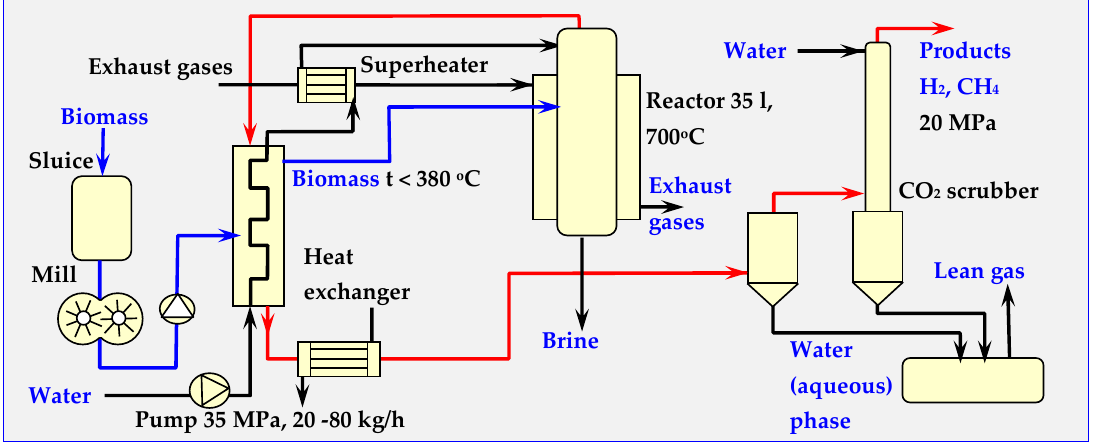
Figure 23. Scheme of the pilot VERENA installation for gasification of Supercritical Water (SCW) biomass [17,182,183].